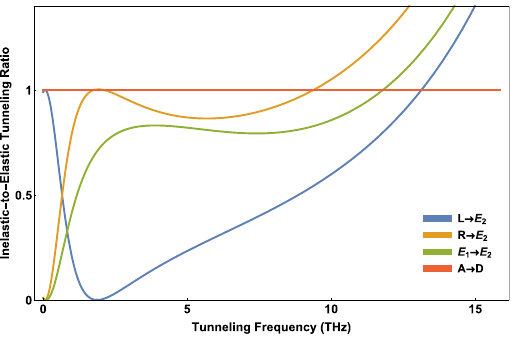
Figure 4. The inelastic-to-elastic ratio versus the tunneling frequency ω x at biological temperature T = 310 K for transitions L → E 2 , R → E 2 and E 1 → E 2 . All figures are plotted at ω z = 10 12